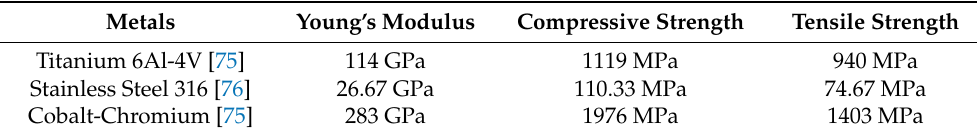
Table 4. Young’s Modulus of metals used as bone implants.